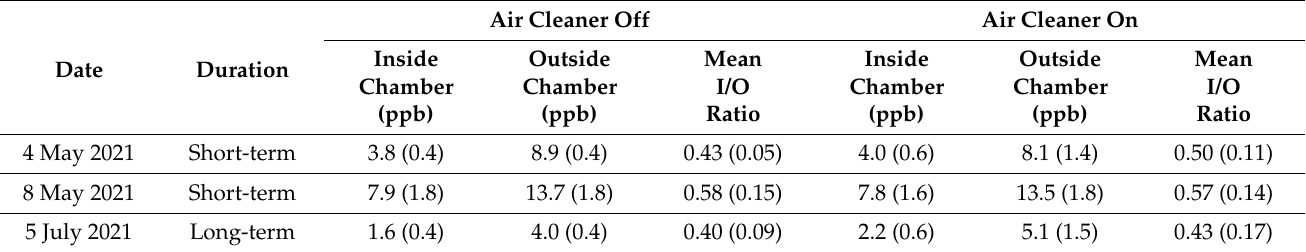
Table 3. Summary of mean (SD) ozone (O 3 ) concentrations measured inside and outside the chamber during three natural condition tests targeting gas-phase organics (VOCs and